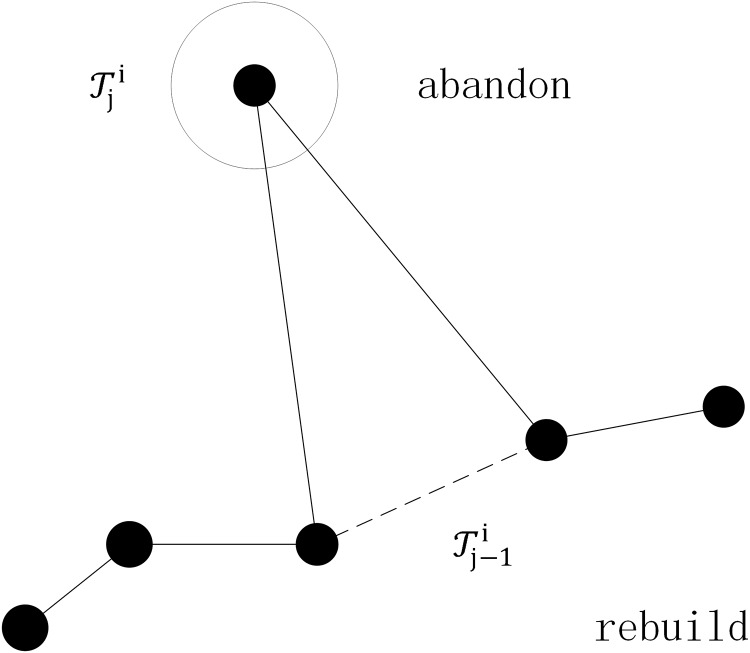
The drift tracing point filtering.